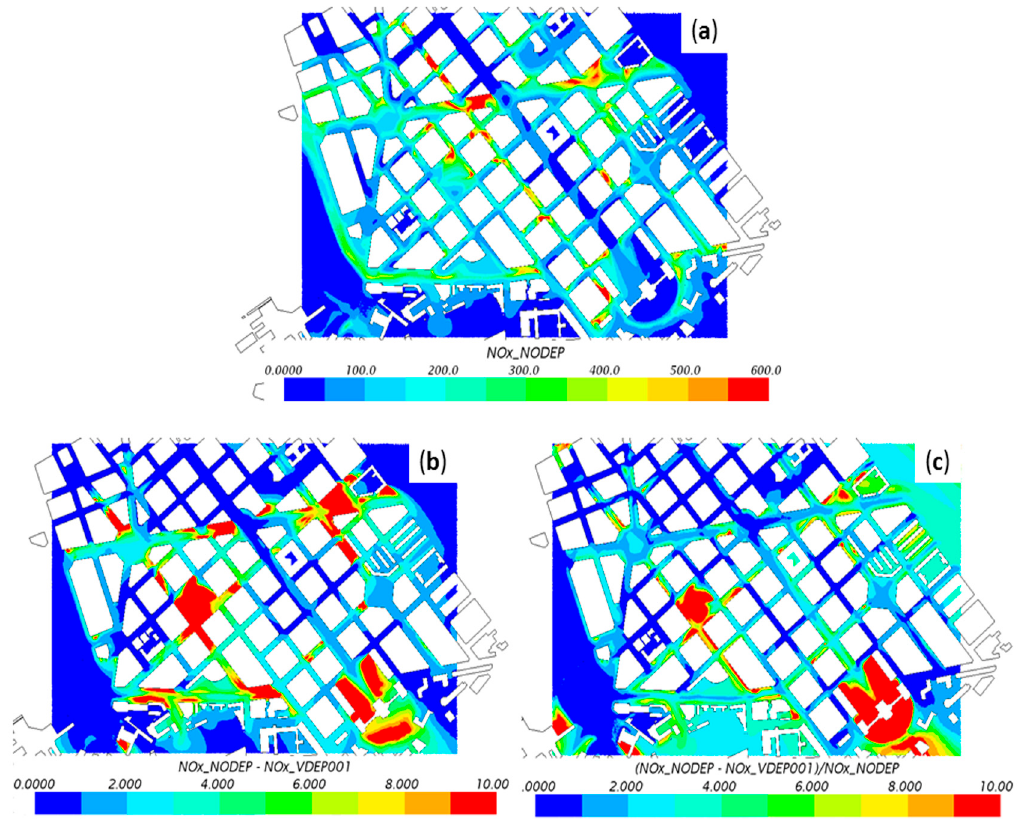
Figure 5. Same as Figure 4, but for Current-2 scenarios (LAD = 0.5 m 2 m − 3 ). Note that red color indicates zones characterized by values higher than 600 µg m − 3 , 10 µg m − 3 , and 10%, respectively. The color scale is the same of that used in Figure 4 for sake of comparison.